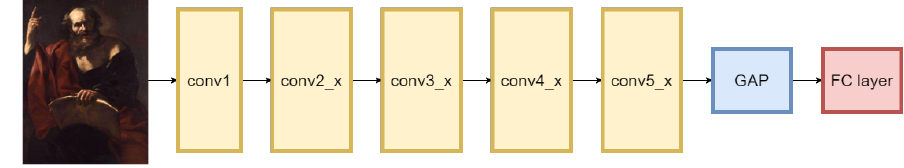
Figure 2. The ResNet50